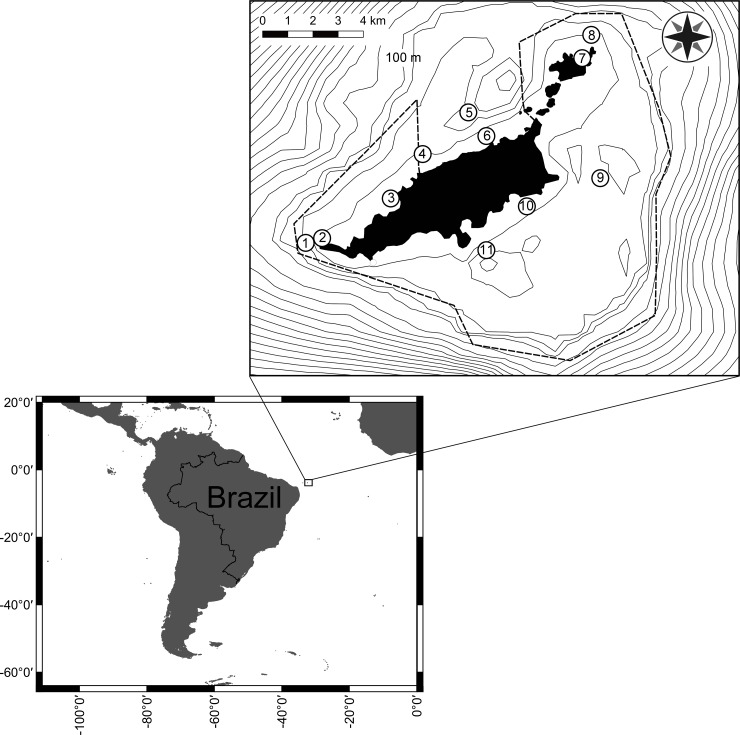
Map of the Fernando de Noronha Archipelago.Sampling sites: 1 –Cabeço da Sapata (CBS), 2 –Caverna da Sapata (CVA), 3 –Baía dos Golfinhos (BG), 4 –Laje Dois Irmãos (LDI), 5 –Cabeço dois Irmãos (CDI), 6 –Morro de Fora (MF), 7 –Buraco do Inferno (BI), 8 –Cabeço das Cordas (CC), 9 –Pedras Secas (PS), 10 –Ilha do Frade (IF) and 11 –Cabeço Submarino (CSU).